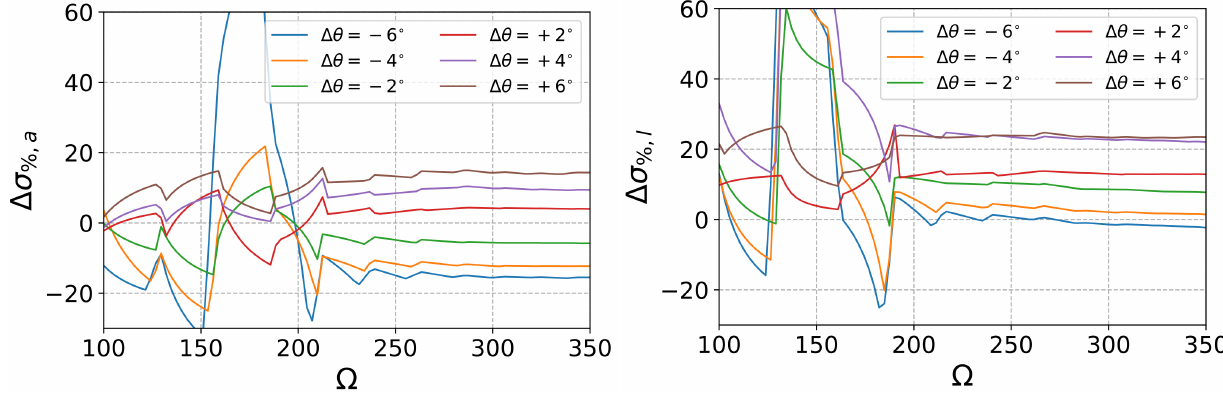
Figure 14. Variation of σ a ( left ) and σ l ( right ) at different oscillation frequencies and ∆ θ for θ = 2 ◦